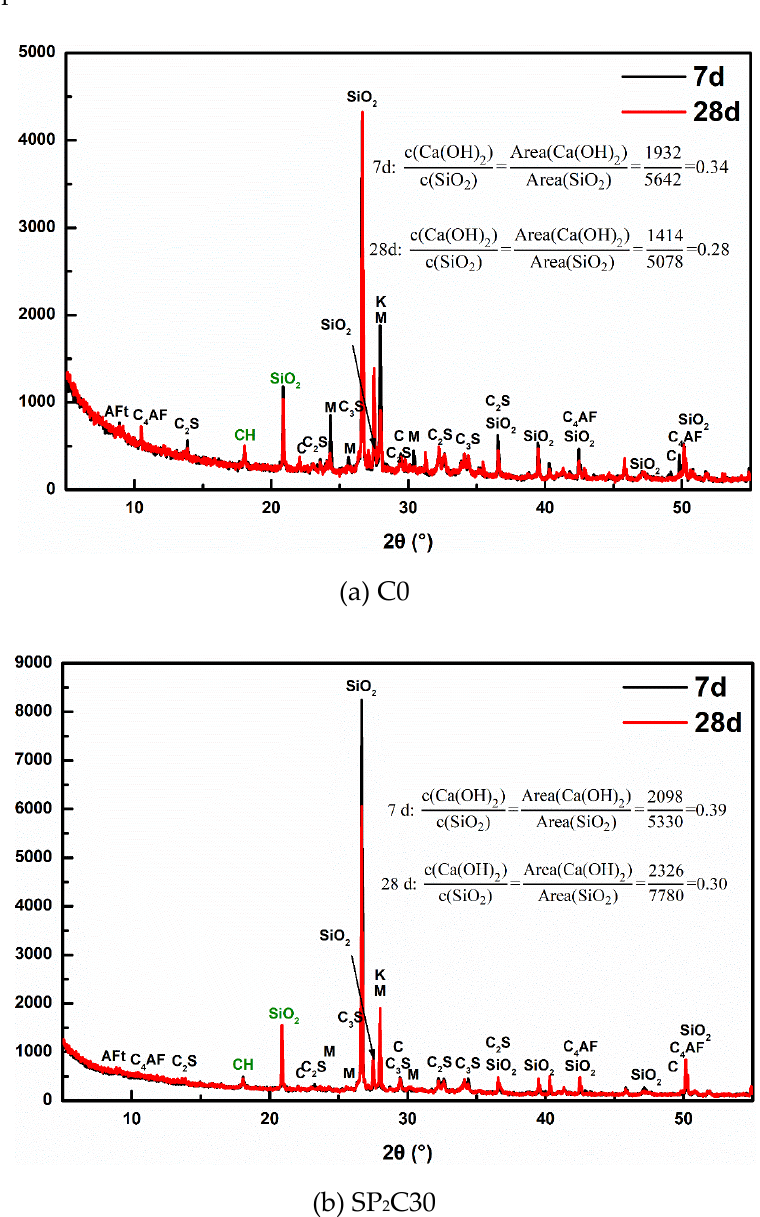
Figure 9. XRD qualitative analysis the content of Ca(OH) 2 in specimens of C0 and SP 2 C30 groups for 7 d and 28 d curing age: ( a ) C0; ( b ) SP 2 C30.